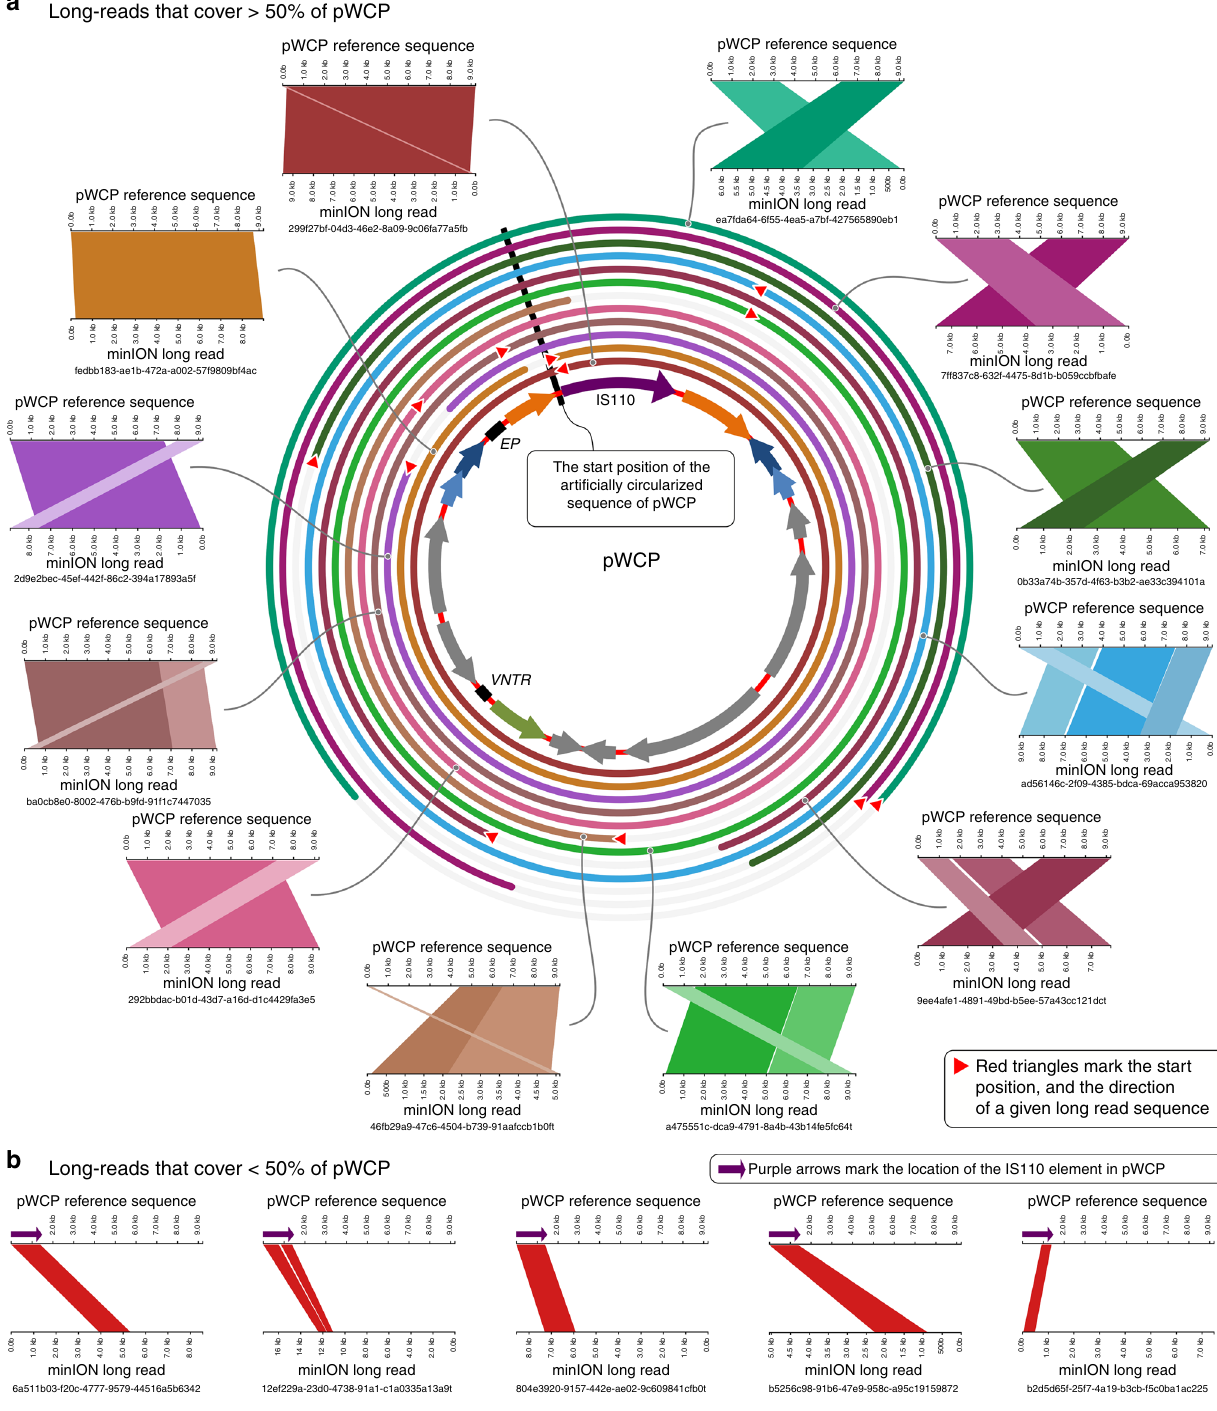
Fig. 2 Alignment of MinION long reads to pWCP. a The alignment of long reads that cover >50% of the pWCP genome (only 12 of 13 total long reads are shown; we omitted 1 from this display solely due to space considerations). Each rectangular fi gure shows high scoring pairs (HSPs) and their alignments between pWCP and long reads. The broken HSPs that are parallel to each other are due to low-quality regions in long read sequences, and they are shown in different shades. Concentric circles around pWCP demonstrate the alignment of each long read and their start and stop positions. b The alignment of long reads that cover <50% of the pWCP genome (only 5 of 6 are shown). Every long read shown in the fi gure has a hit to the IS110